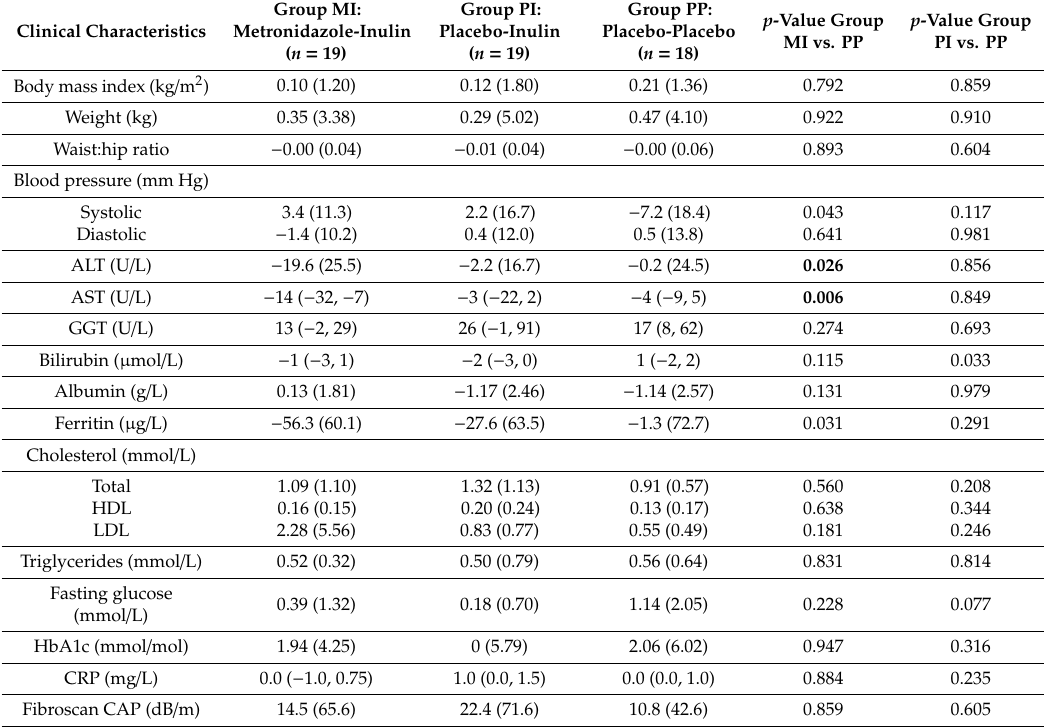
Table A2. Changes in characteristics at week 16, after 12 weeks of treatment following randomisation to metronidazole / inulin, placebo / inulin or placebo /